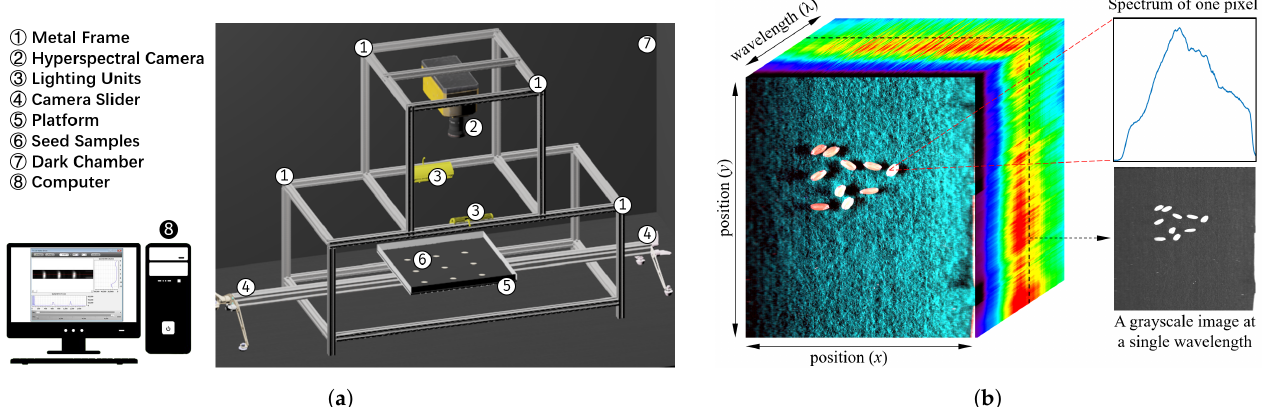
Figure 2. Hyperspectral imaging (HIS) system: ( a ) HyperSeed platform; ( b ) a generated hypercube of test-case seed